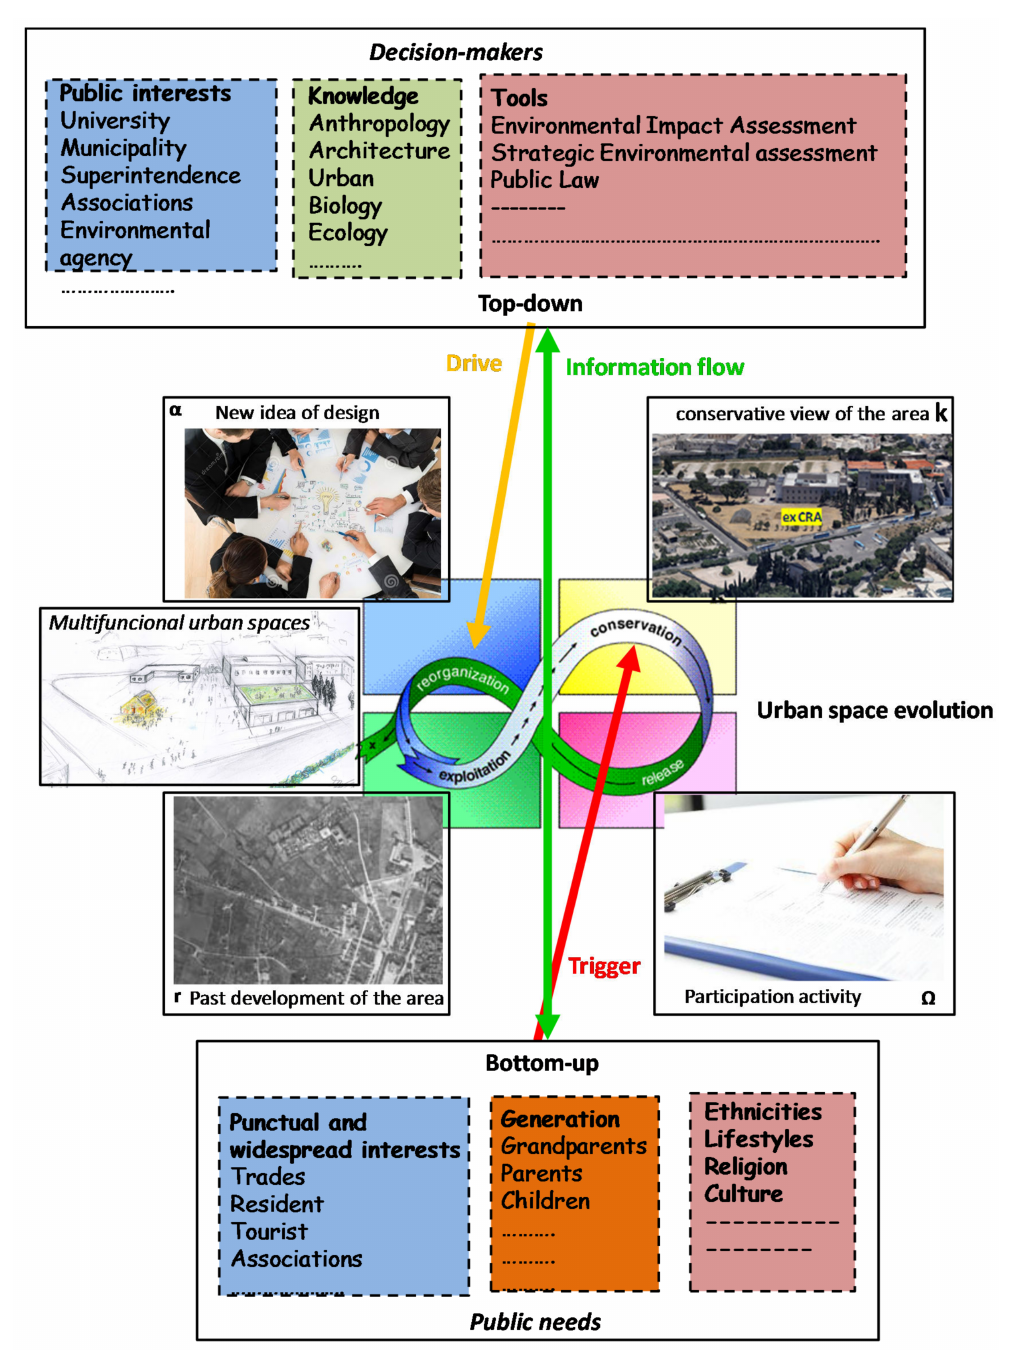
Figure 14. Contribution of the combination of bottom-up and top-down participation approaches in transdisciplinary planning and design of the urban space evolution considered as the socio-ecological system